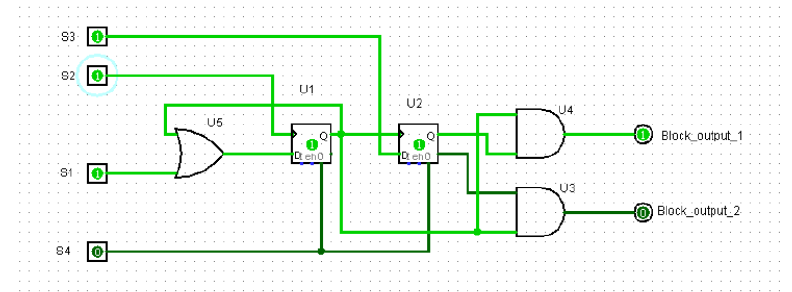
Figure A1. Block circuit (Logisim).